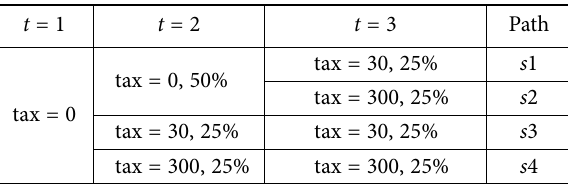
Table 4. Carbon tax scenario paths and probabilities